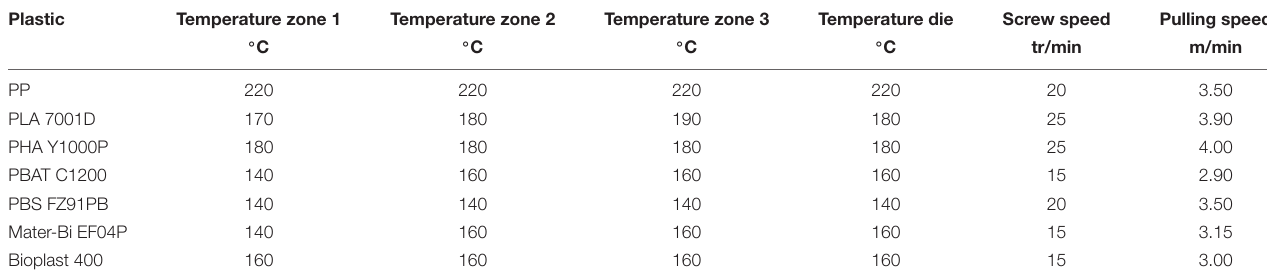
TABLE 1 | Extrusion conditions for the different plastic